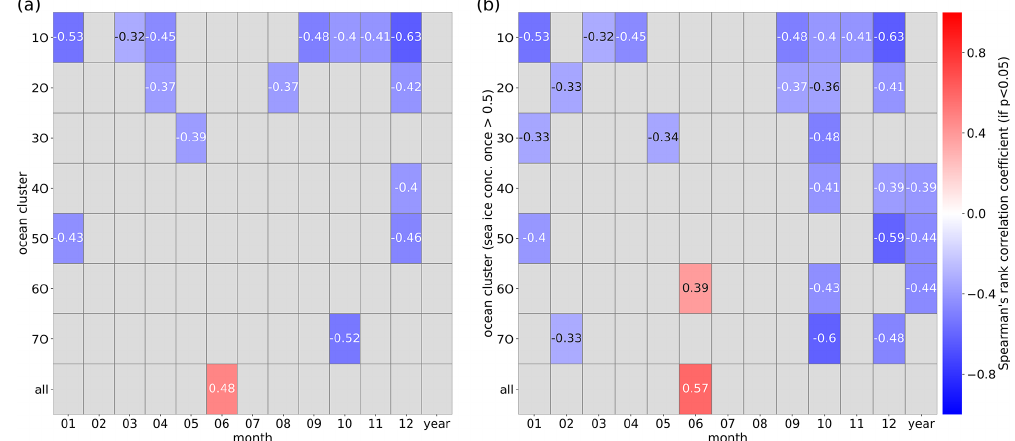
Figure 12. (a) Spearman’s rank correlation coefficients between moisture sources from each ocean cluster against relative ice area for each month and year. If there is no significant correlation ( p value ≥ 0.05), the corresponding box is shaded in grey. (b) Same as in (a) but looking only at the area of those ocean grid points that had a sea ice concentration of above 0.5 during the study period (effectively reducing each cluster’s area to the sea-ice-relevant areas). The legend for the used cluster abbreviations is in Fig. 8a and